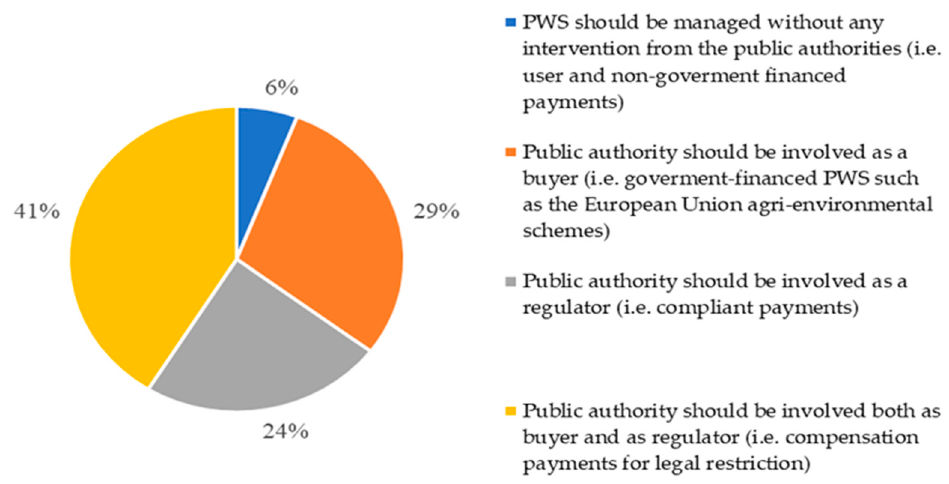
Figure 2. The stakeholders’ opinions on what the role of public authorities should be in PWS schemes in Slovakia (Q2).